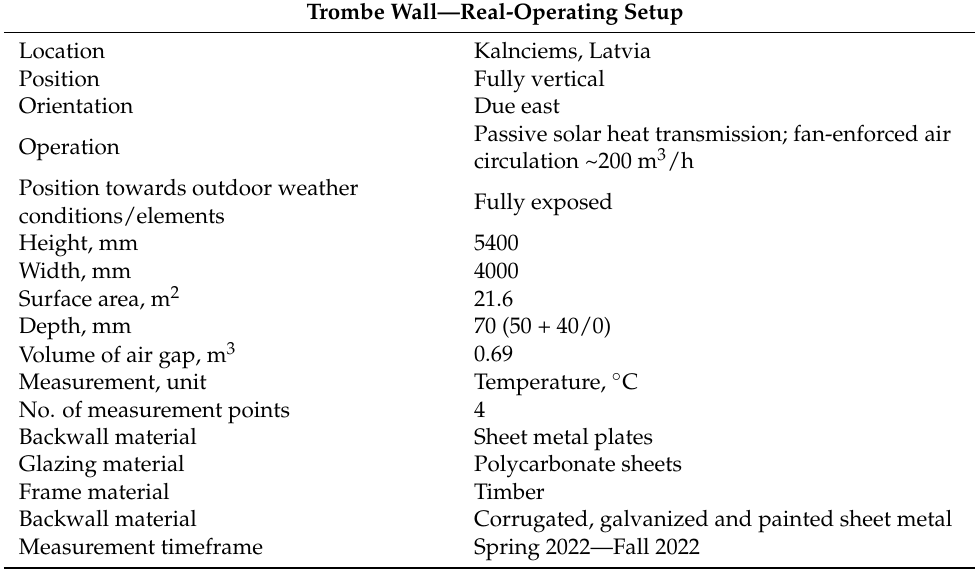
Table 2. Trombe wall structure’s profile. Trombe Wall—Real-Operating